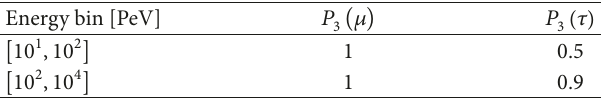
Table 1: Numerical values of 𝑃 3 (𝐿) for the different energy ranges considered in this